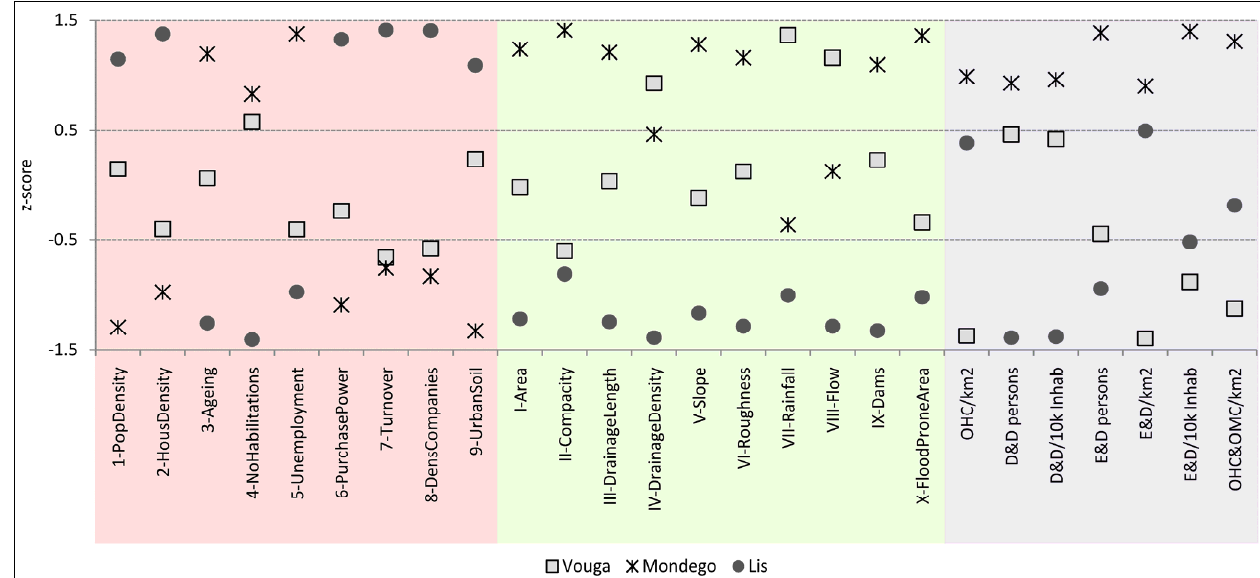
Figure 8. Comparison of Vouga, Mondego and Lis basins in terms of socio-economic ( red shadow ); hydrographic ( green shadow ) and impact variables ( blue shadow